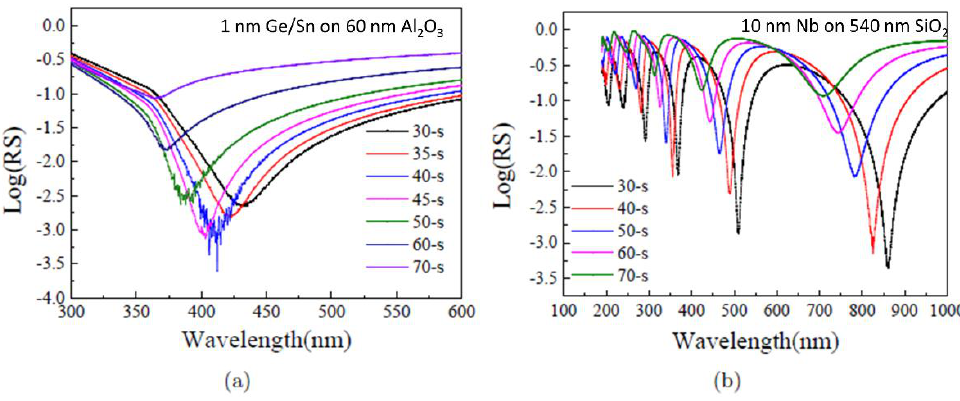
Figure 7. The dependence of the reflectivity measured at different angles of light incidence to the plane in triple and quadruple layer meta-surfaces. The n-doped Si was used as a substrate in all experiments. The incident light had s-polarisation. The light angle is measured from the normal to the meta-surface plane. The logarithm of reflectivity is shown, reflectivity RS is given as absolute value. The value of the incident angle is shown in different colours in the figure panel. ( a ) Quadruple layer meta-surface made of Si/Al 2 O 3 /Ge/Sn. ( b ) Triple layer meta-surface made of Si/SiO 2 /Nb. Note, that the lowest reflectivity value of 0.0002–0.0003 for both types of meta-surfaces is obtained at an angle of 40° (blue line) in Si/Al 2 O 3 /Ge/Sn and at an angle of 30° (black line) in Si/SiO 2 /Nb films. For Nb meta-surfaces multiple minima in reflectivity are observed, which may be related to the thicker oxide layer in this structure.